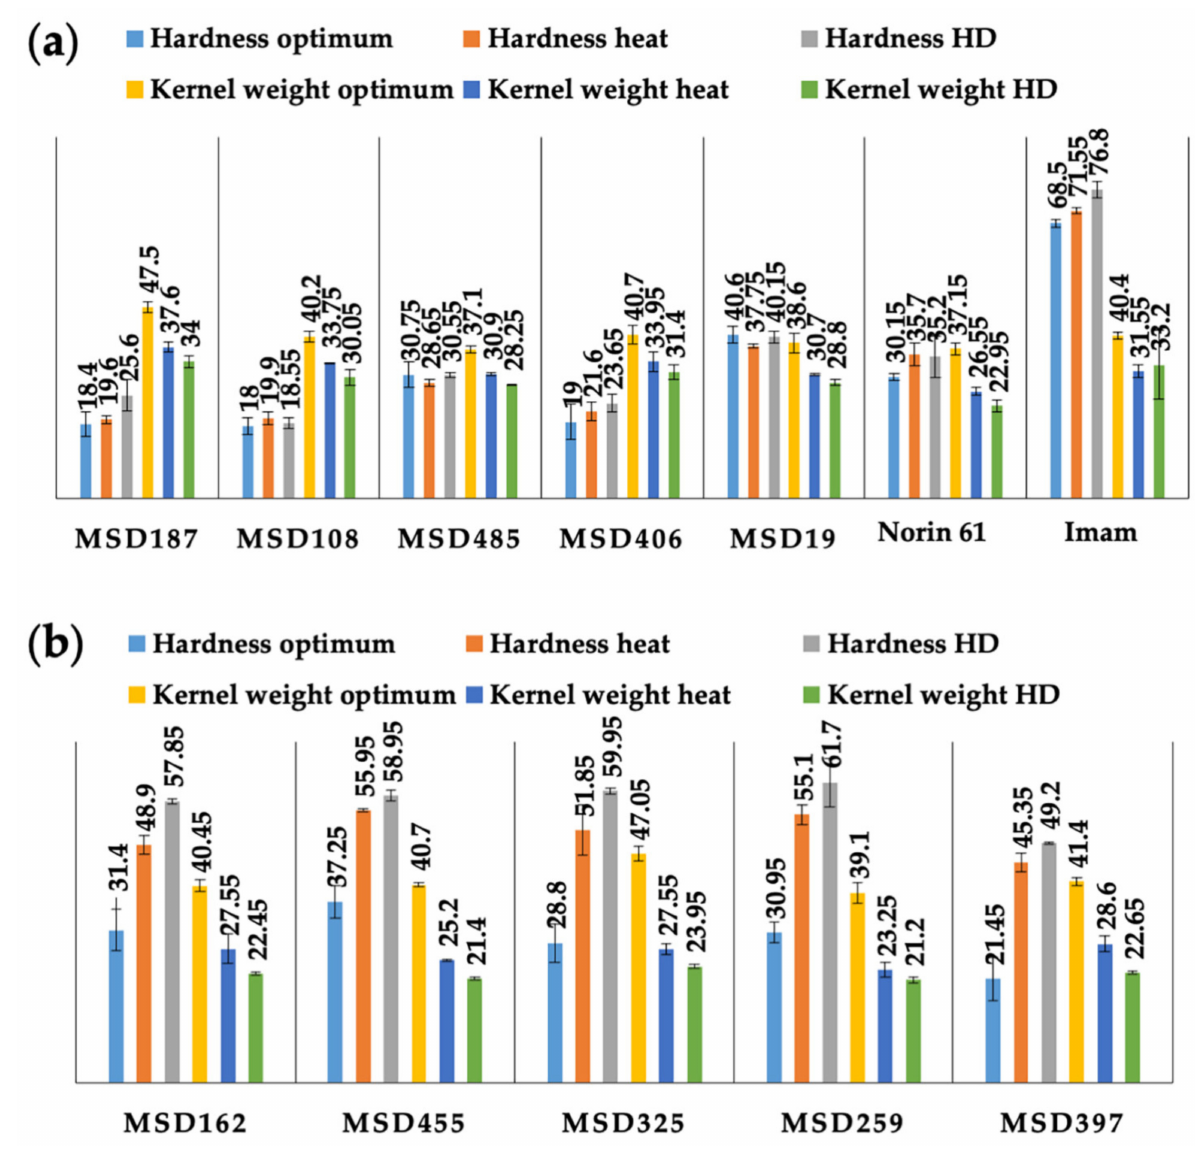
Figure 3. Relationship between hardness and kernel weight for the multiple synthetic derivative (MSD) lines tolerant ( a ) And sensitive ( b ) lines under optimum, heat and combined heat-drought (HD), ‘Norin 61’ is the background parent and ‘Imam’ is a heat-tolerant Sudanese